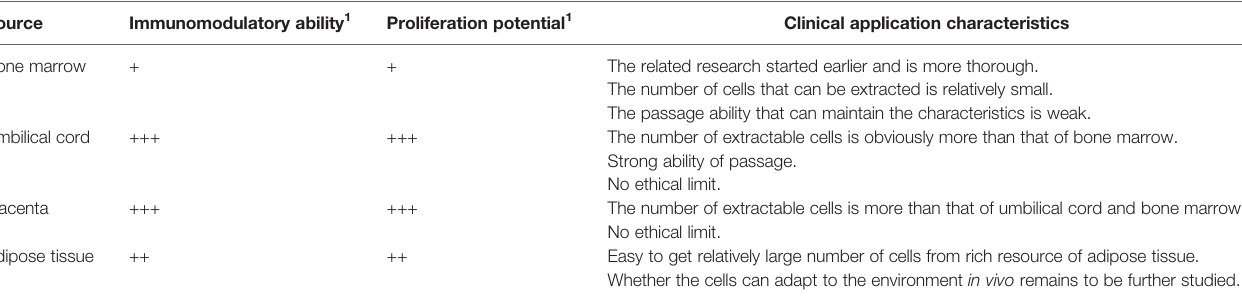
TABLE 2 | Immunomodulatory ability, proliferation potential, and clinical application characteristics of MSCs from different sources.